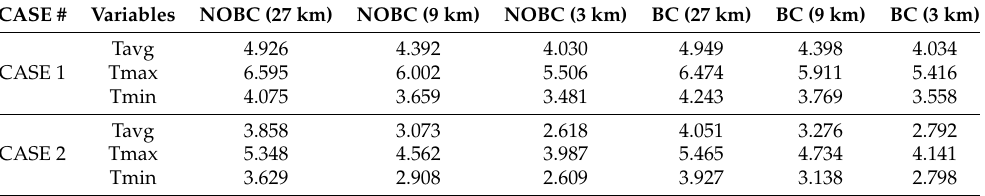
Table 1. Averaged RMSE ( ◦ C) for 94 stations.